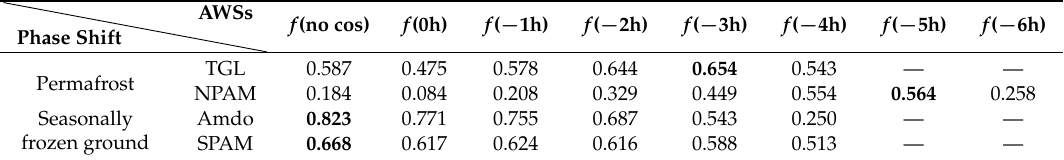
Figure 5. The relationship between G 0 and f ( Γ Ma , R n , c , t ) under the different phase shifts in TGL. Table 6. The coefficient of determination R 2 of the linear relationship between f ( Γ Ma , R n , c , t ) and G 0 at the four stations with different phase shifts c .